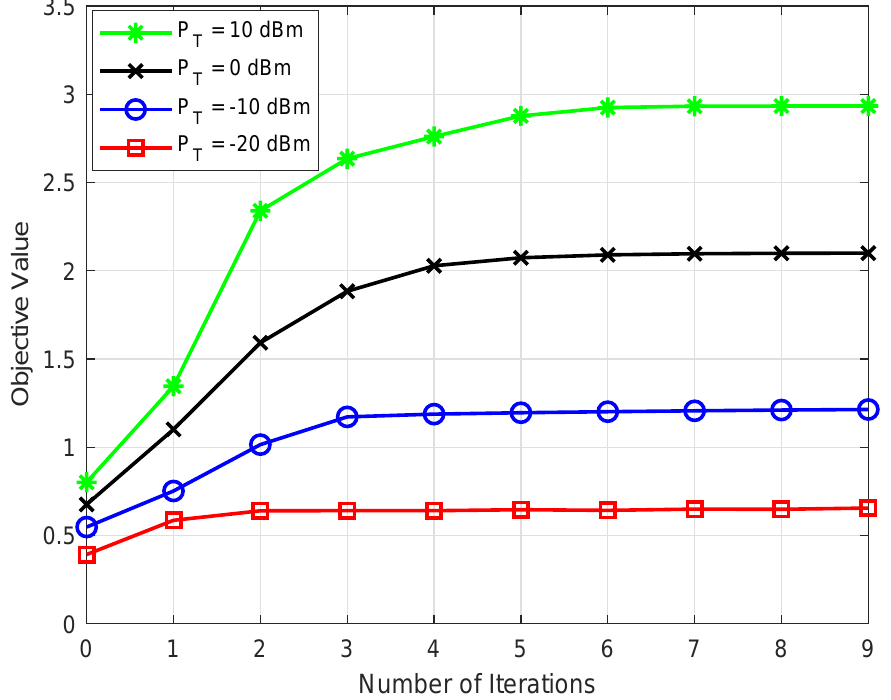
Figure 2. Average convergence performances versus the number of iterations for a = 0.5. The EE-SE trade-off curves attained by the algorithm framework under different values of BS power constraint P T and weight a are shown in Figure 3. Obviously, EE-SE trade-offs under different weighting factors are similar to each other when the value of P T is small, approximately when P T < 20 dBm, as all available power of BS can be fully utilized and both EE and SE are maximized when P T is small. Therefore, changes in values of a have little impact on the EE-SE trade-off when P T is small. When P T gets high, the EE-SE trade-offs under different a differ greatly. It is observed that the increasing of a brings about an increase in EE optimization and a decrease in SE, and the decreasing of a causes a decrease in EE and an increase in SE. That is because larger weight is given to EE for larger a , and thus more focus is transferred to EE when conducting the optimization. However, more focus is transferred to the SE optimization when a smaller weight is given to EE for smaller a